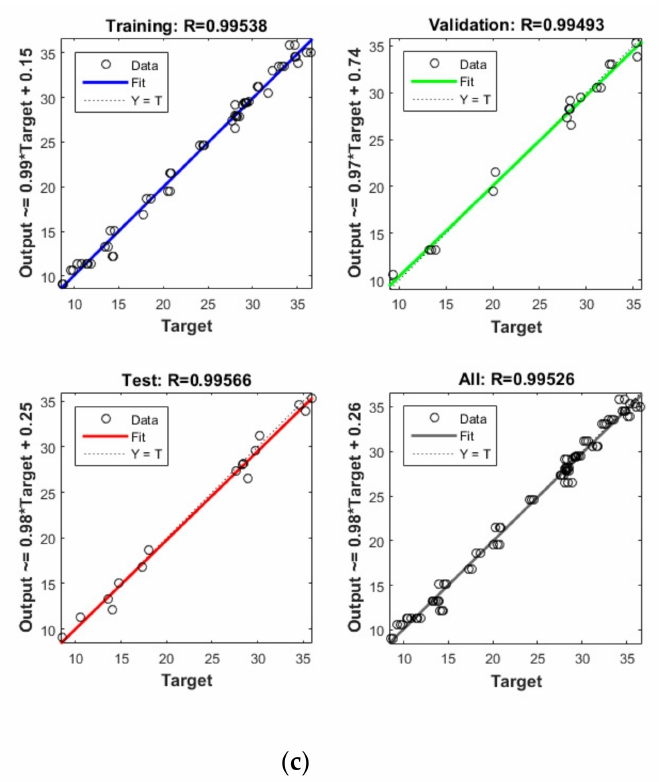
Figure 4. Model prediction versus experimental values for the removal of CBZ ( a ), SMT ( b ) and TRA ( c ) by the first reactor.